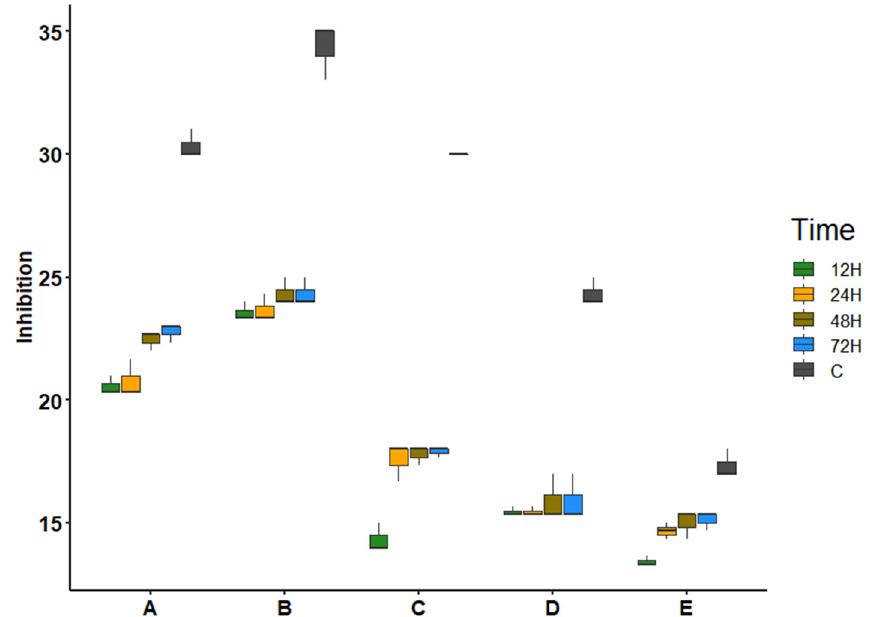
Figure 6. Box plot of the effects of bacteria and time on inhibition: ( A ): Escherichia coli ATCC 25922; ( B ): Escherichia coli O157:H7; ( C ): Escherichia coli UPEC phylogroup A; ( D ): Escherichia coli UPEC phylogroup B2; ( E ): Serratia sp.